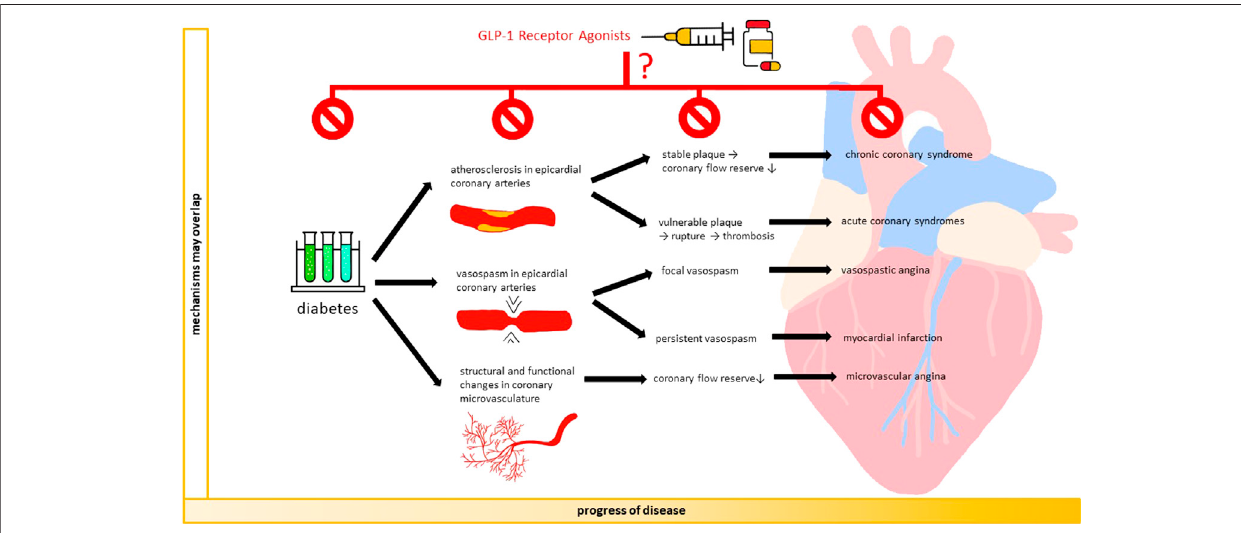
FIGURE 1 | GLP-1 RAs and coronary arteries: from mechanisms to events. GLP-1 receptor agonists may prevent the development and progression of coronary atherosclerosis, vasospasm of epicardial coronary arteries, and structural/functional changes in coronary microvasculature. By occurring alone or concomitantly, these mechanisms reduce coronary blood fl ow and may result in coronary events, including acute coronary syndrome, chronic coronary syndrome, vasospastic angina, and microvascular